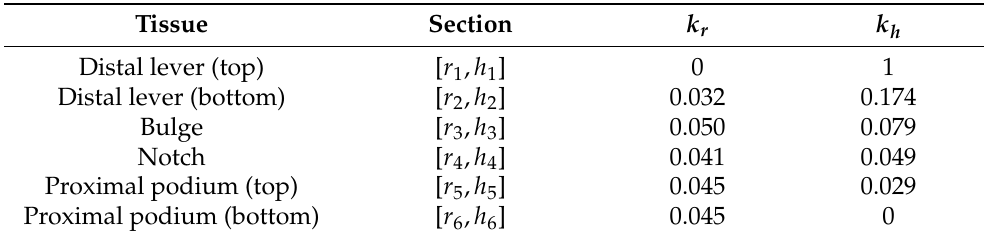
Table 1. Normalized heights h i and radii r i of characteristic sections, averaged for three sensory hairs, are expressed as linear functions: r i = k r ⋅ h ∗ and h i = k h ⋅ h ∗ , where h ∗ is the normalized total hair